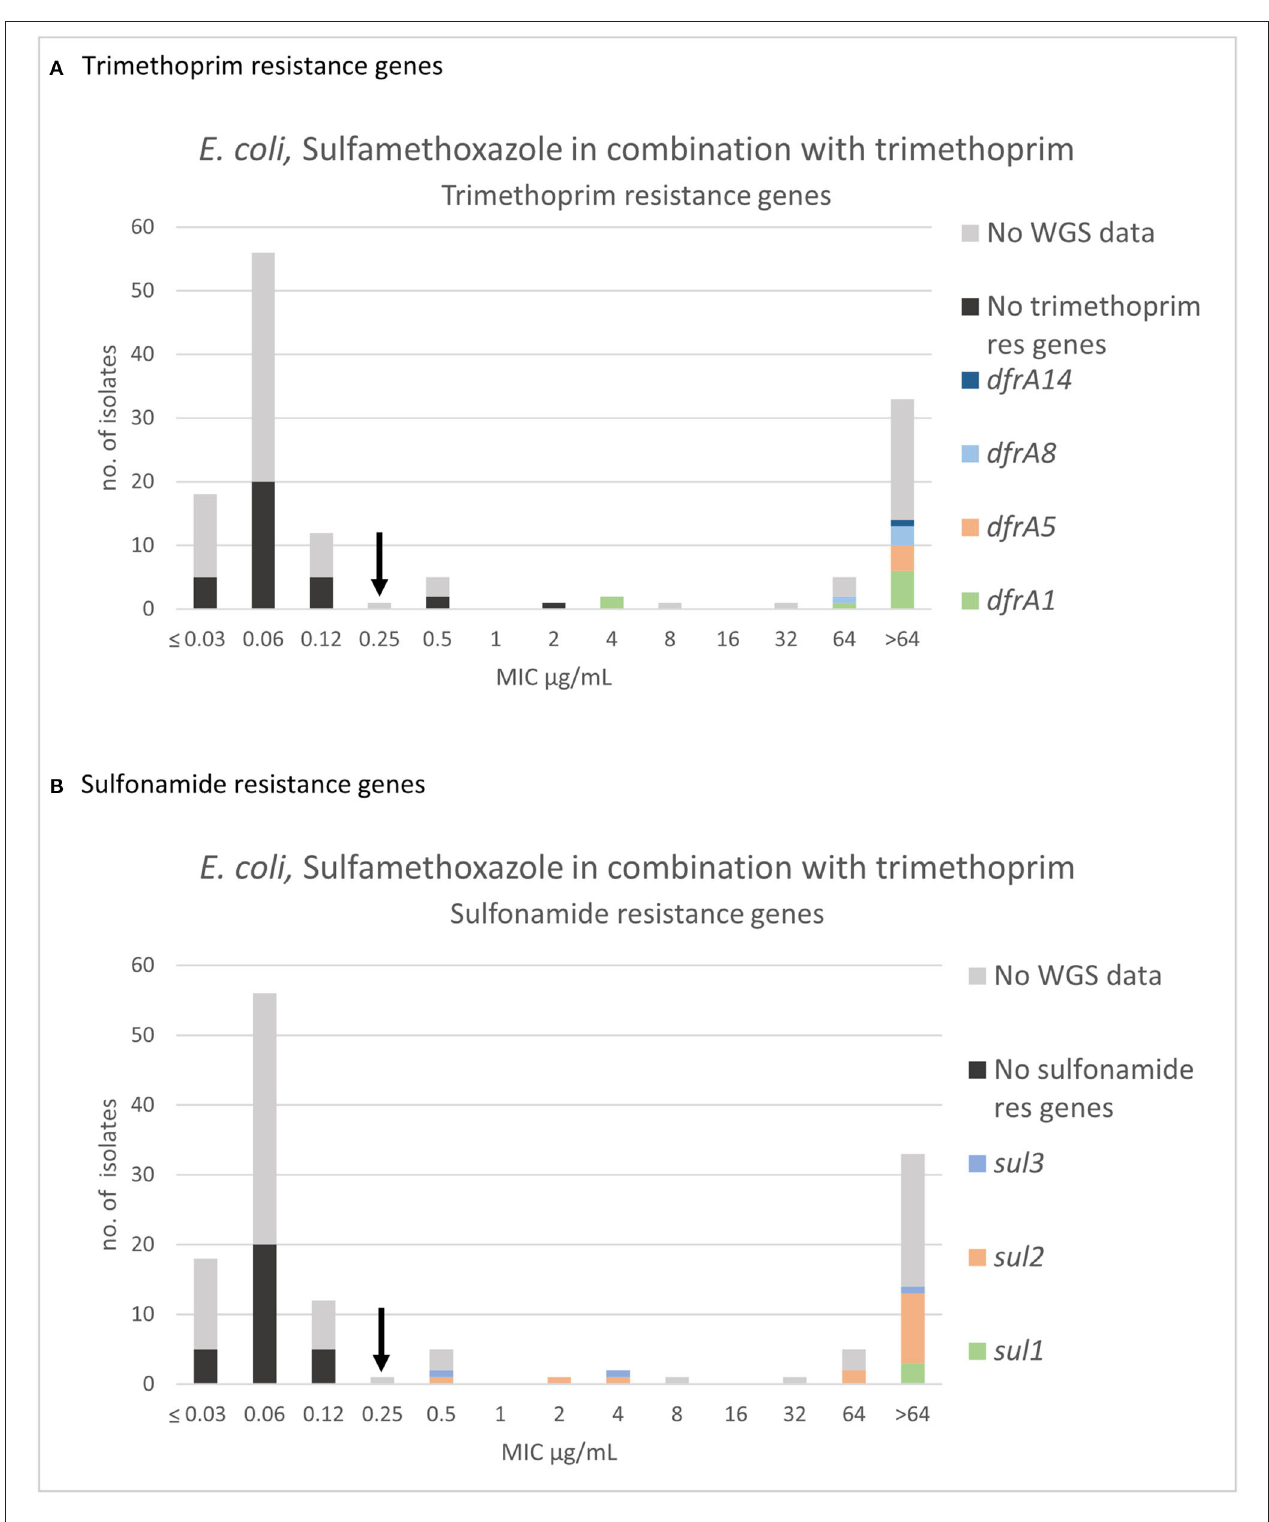
FIGURE 6 | MIC distribution of E. coli ( n = 135) against sulfamethoxazole in combination with trimethoprim (19:1) in the test range of 0.03–64 µ g/mL. The arrow indicates the epidemiological cut-off value (ECOFF, EUCAST). Colors indicate if the isolates have been sequenced ( n = 51) and whether they harbor known (A) trimethoprim resistance gene and/or (B) sulfonamide resistance genes. WGS, whole-genome sequencing; res, resistance.